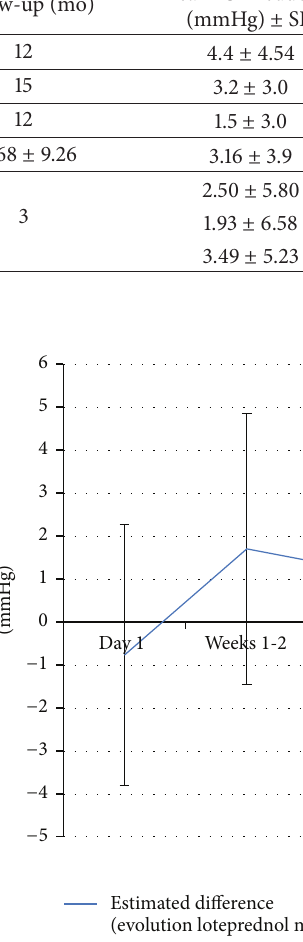
Figure 2: Estimated IOP evolution difference (evolution lotepred- nol minus evolution prednisolone), adjusted for preoperative IOP difference. For instance, the IOP evolution of loteprednol was 0.7676 mmHg lower than that of prednisolone on day